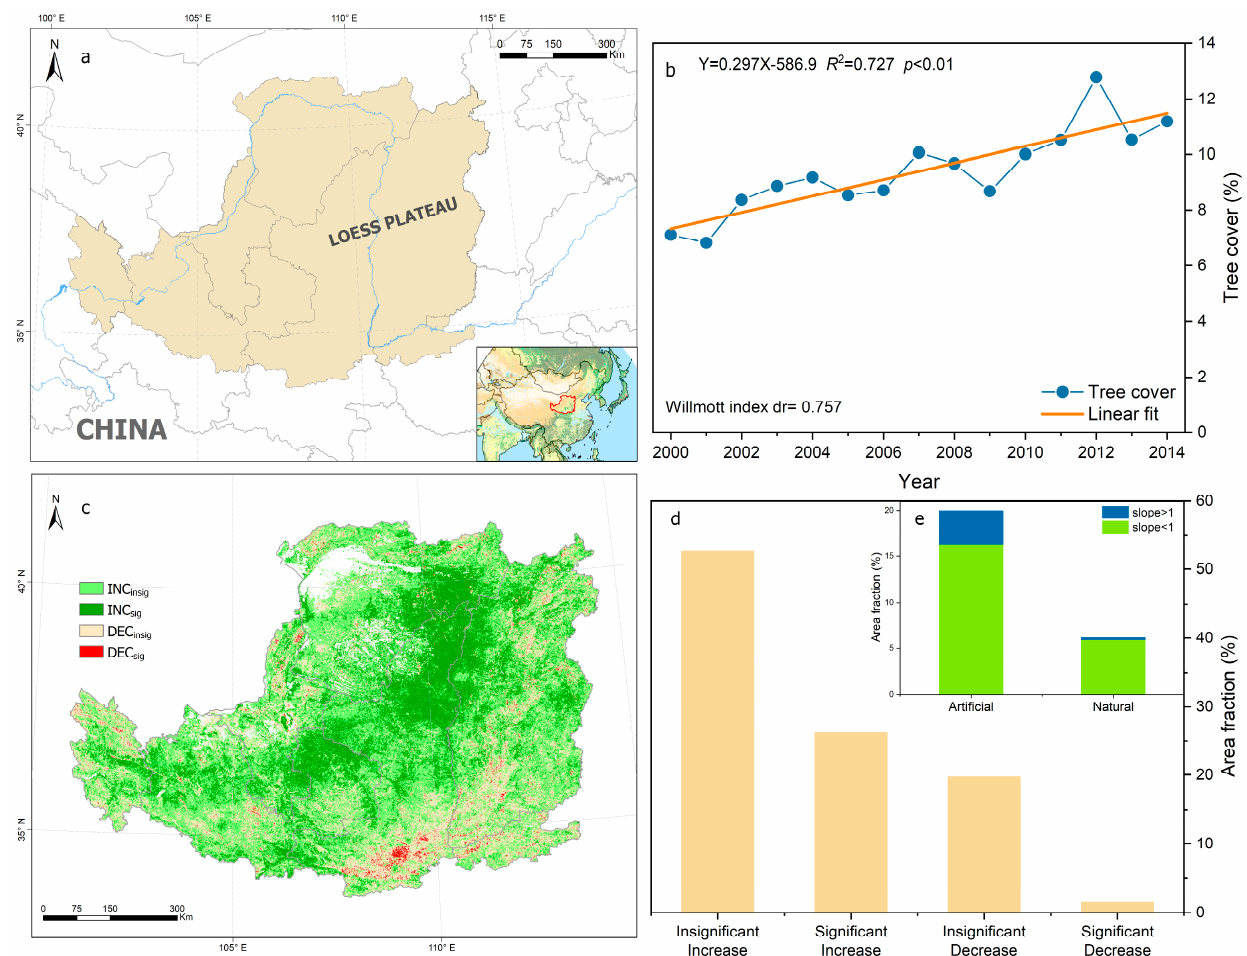
Figure 1. ( a ) Location of the Loess Plateau with respect to the national boundary of China. ( b ) Tempo- ral trend of VCF tree cover in 2000–2014 (linear regression function y = 0.297x − 586.912, R 2 = 0.727, p < 0.01, Willmott index dr = 0.757). ( c ) Map for the significance of VCF tree cover trend, INC insig : tree cover increased insignificantly ( p ≥ 0.05); INC sig : tree cover increased significantly ( p < 0.05); DEC insig : tree cover decreased insignificantly ( p ≥ 0.05); DEC sig : tree cover decreased significantly ( p < 0.05). ( d ) Area fraction of tree cover change in Loess Plateau and a fraction of significant increase areas ( p < 0.05) caused by artificial forest and natural forest. The blue bar indicates highly increased tree coverage (HI) with a trend slope larger than 1, while the green bar indicates limited increased tree coverage (LI) with a trend slope smaller than 1).